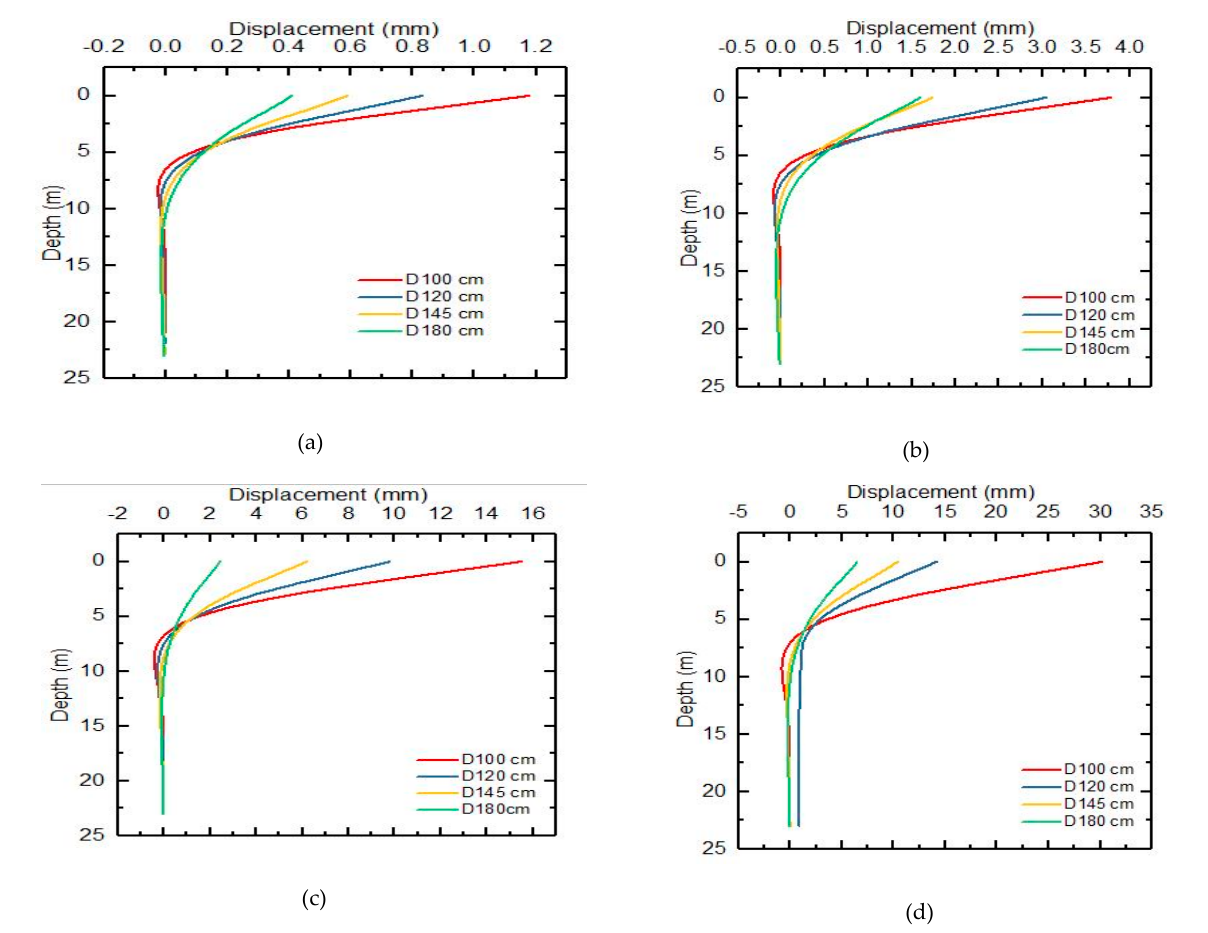
Figure 15. Impact of diameter on the displacement distribution along of reinforced concrete pile; ( a ) The displacement of the pile in the function of different diameters at load 110,000 N; ( b ) The displacement of the pile in the function of different diameters at load 440,000 N; ( c ) The displacement of the pile in the function of different diameters at load 1,100,000 N; ( d ) The displacement of the pile in the function of different diameters at load 1,650,000 N.